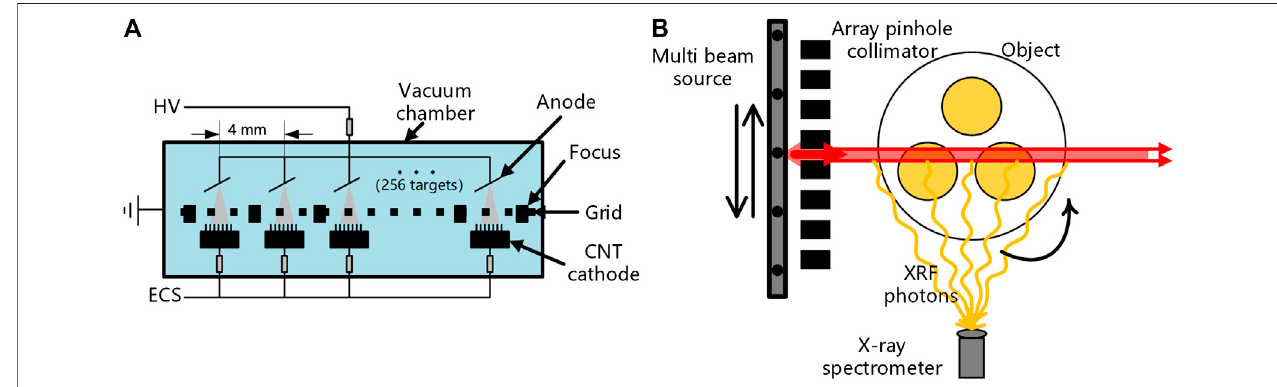
FIGURE 1 | (A) Structure of the spatially distributed multi-beam source in this study and (B) geometry of the X-ray fl uorescence computed tomography system.